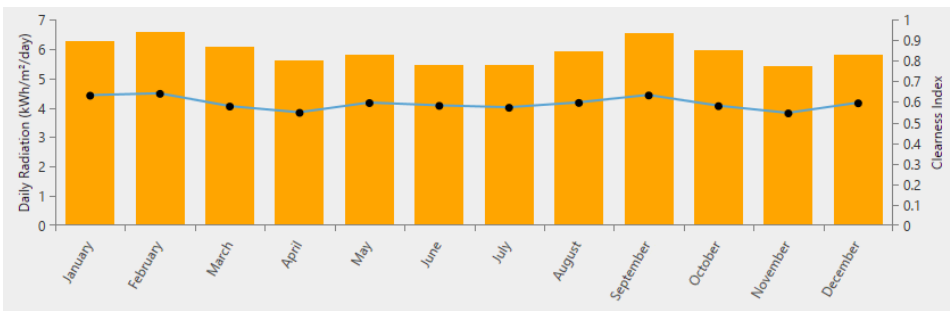
Figure 4. Assumed average daily solar irradiation and clearness index for the plant location.